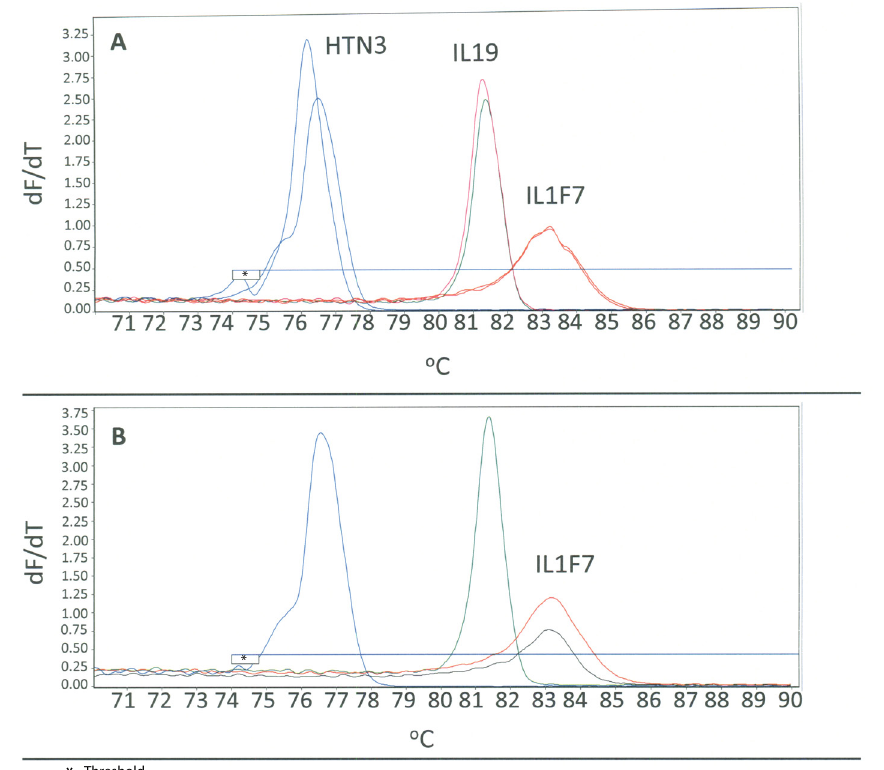
Figure 5. Epithelial cell triplex HRM assay. A Triplex HRM assay was created to permit identification of epithelial-cell containing tissues and fluids (saliva, vaginal secretions and skin). A ) A body fluid specific marker for each of the three fluids/tissues was incorporated into a single reaction (HTN3 – saliva, IL19 – vaginal secretions, IL1F7 – skin). Each individual sample was analyzed using a single triplex reaction. Two saliva donors (blue), one vaginal secretions (green) and one menstrual blood donor (pink) and two skin donors (orange) are shown